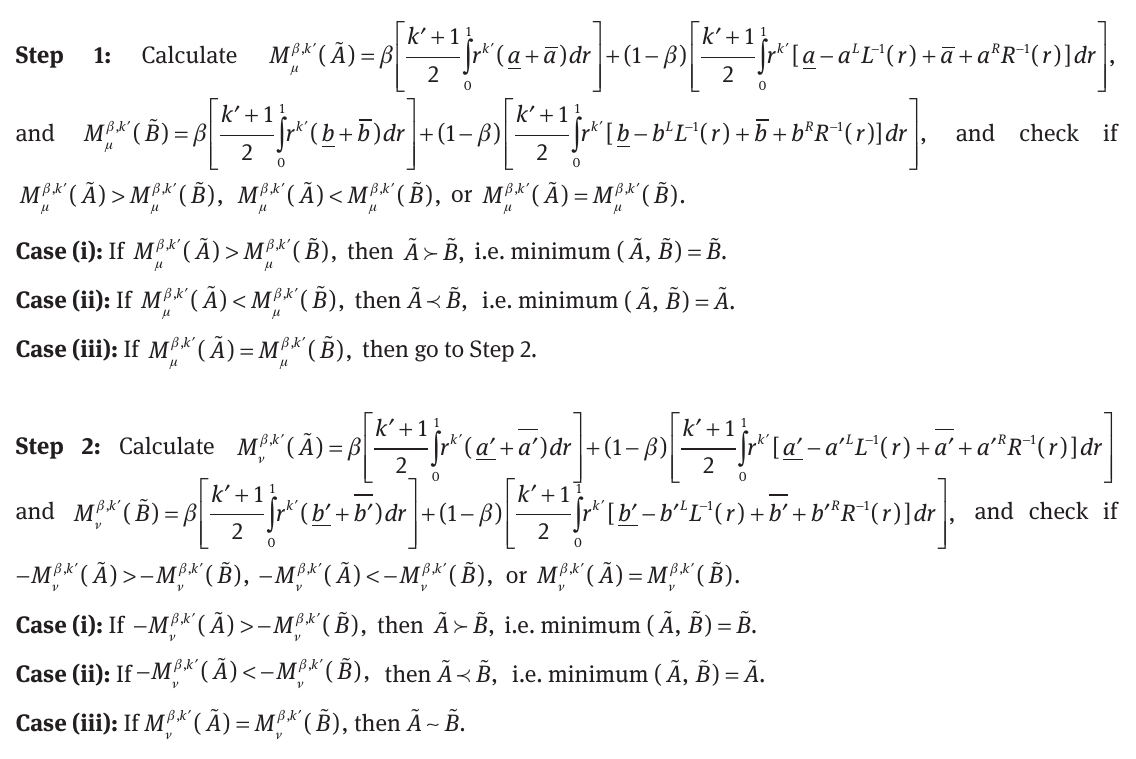
Where L ( x ) = maximum{0, 1 − x }, R ( x ) = maximum{0, 1 − x